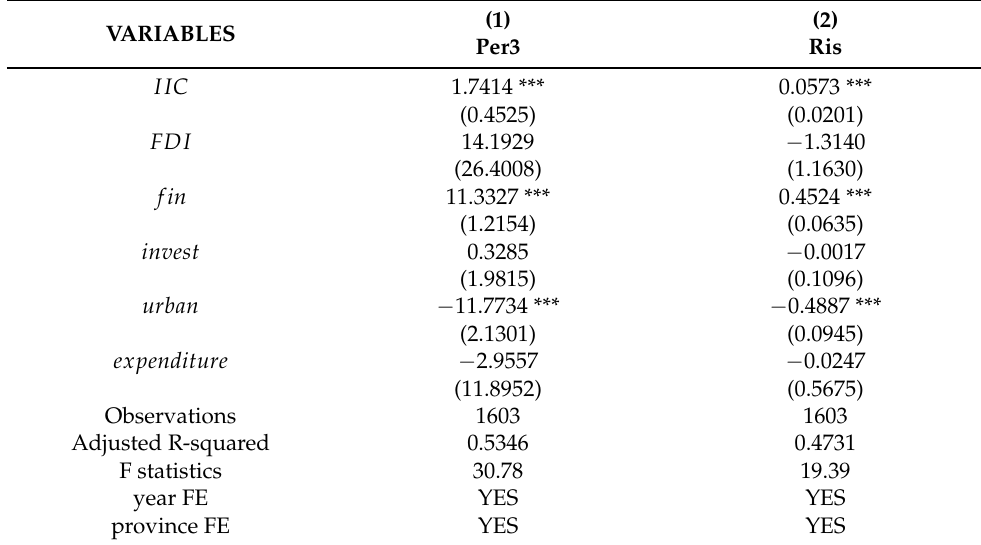
Table 7. Mechanism test: industrial structure